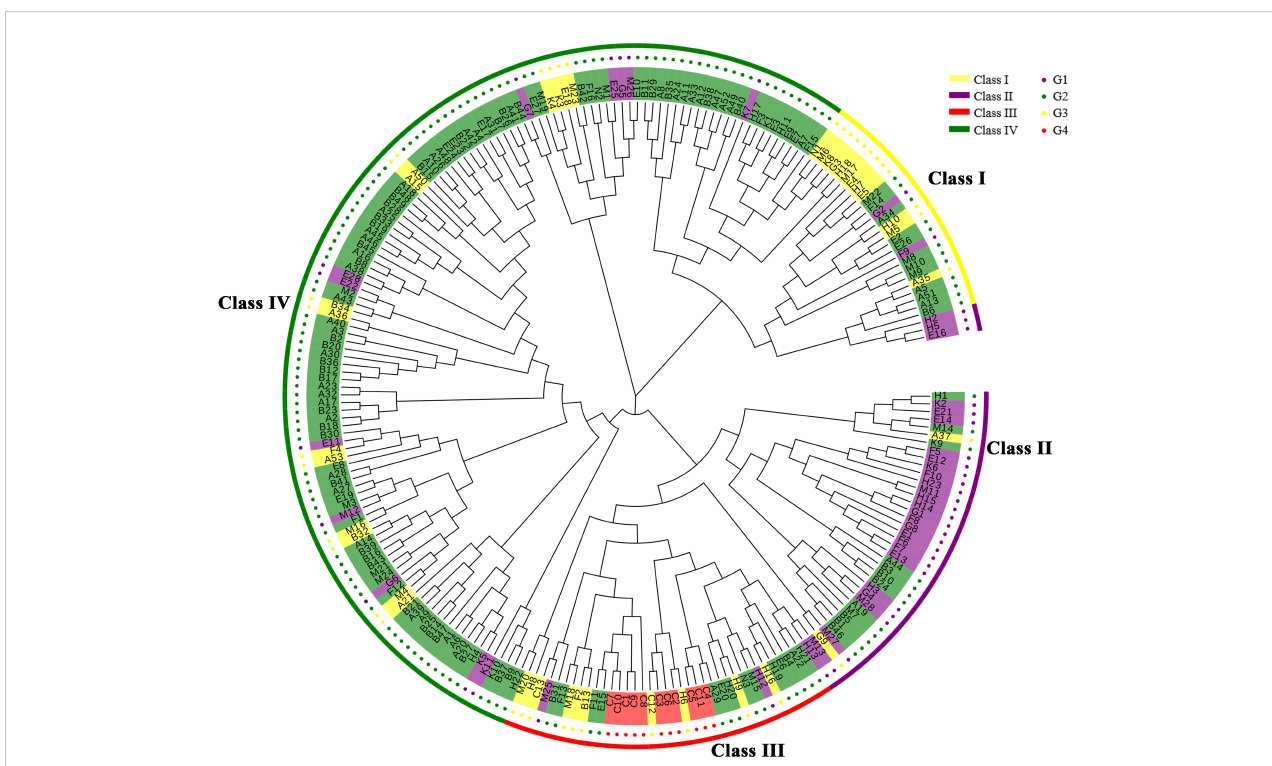
FIGURE 2 The Chinese fi r germplasm phylogenetic tree. The outermost circle in yellow indicates Class I, purple indicates Class II, red indicates Class III, and green indicates Class IV; the inner circle in red indicates G4, yellow indicates G3, green indicates G2 and purple indicates G1.